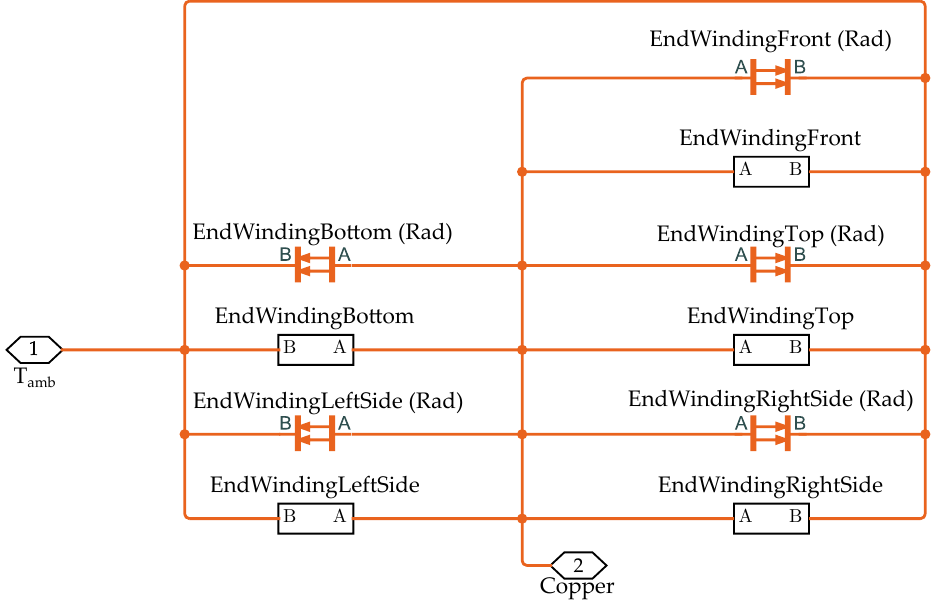
Figure 5. Thermal network for the end windings.